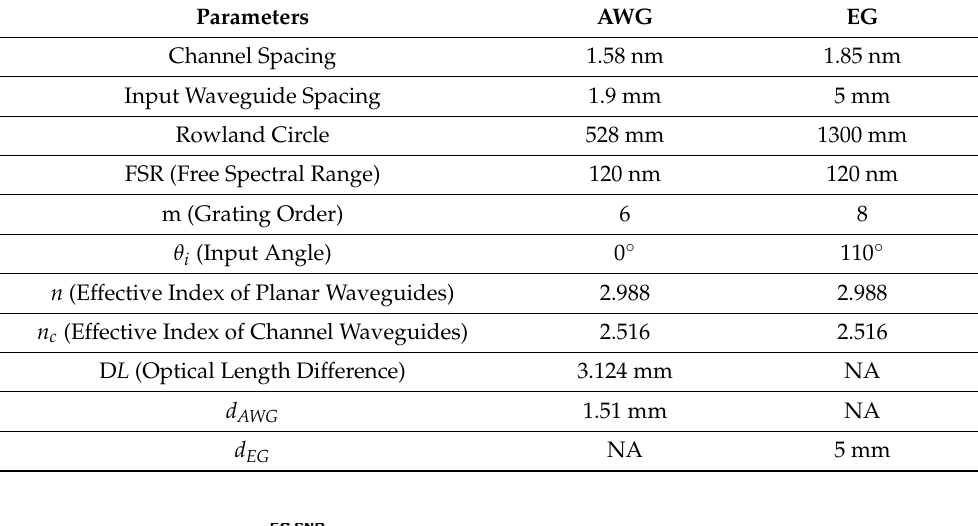
Figure 11. PSF from the MZDC interrogated with AWG. Table 2. AWG & EG design parameters. Table 2. AWG & EG design parameters .